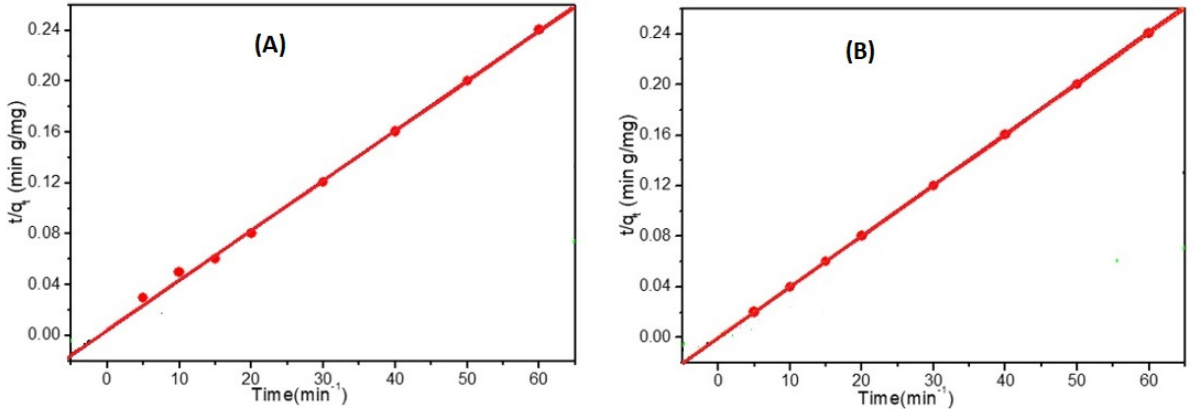
Figure 8. Adsorption % of heavy metal using different concentration of heavy metal ions at pH 5 and contact time 2 h.